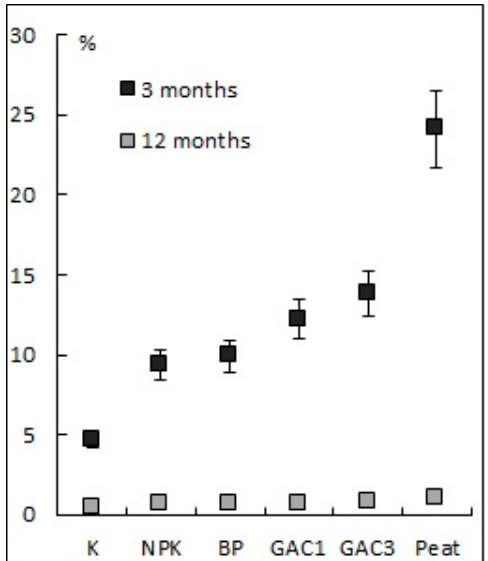
Figure 4. The change of the soil humidity due to the bioremediation.